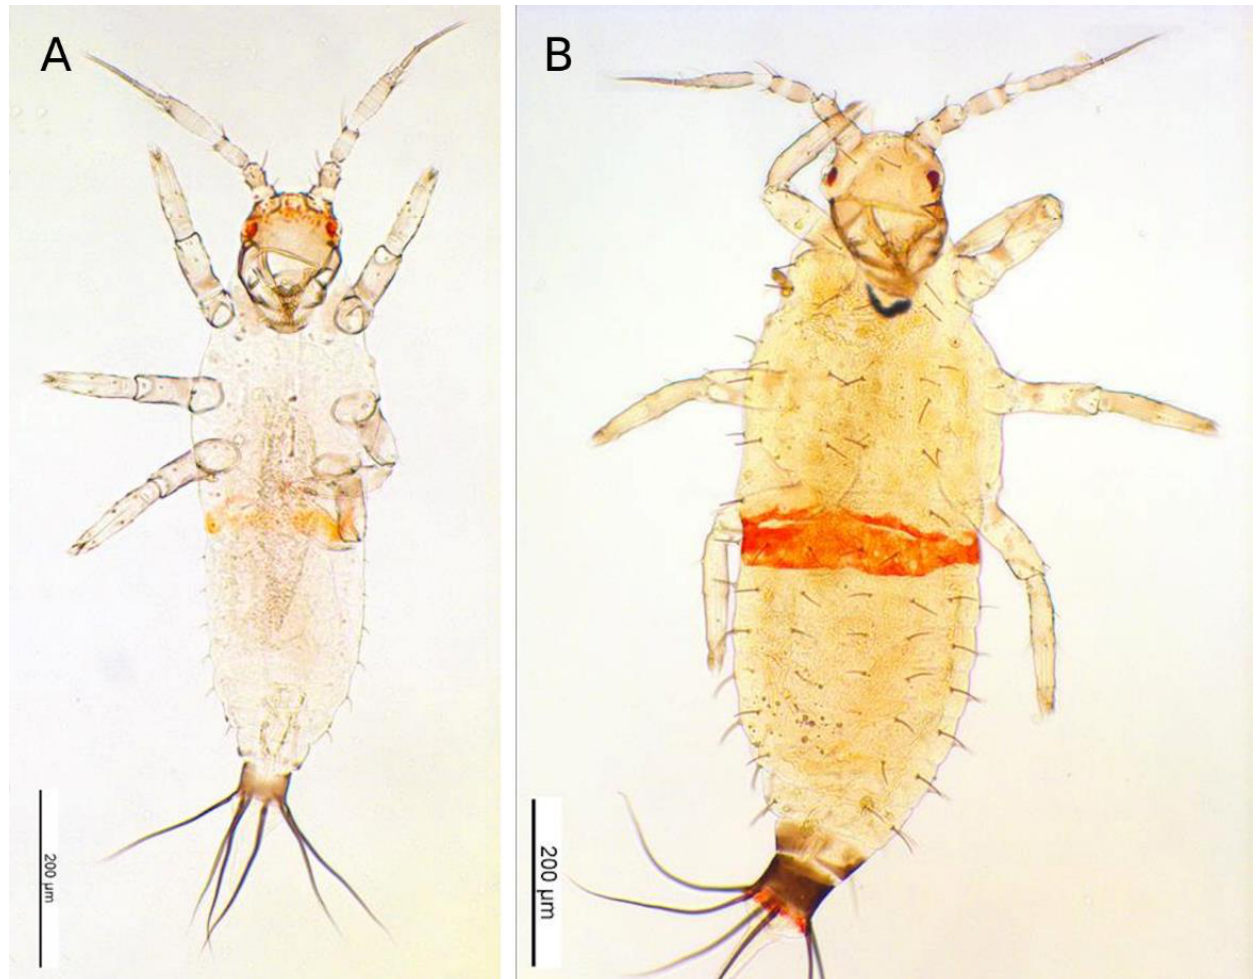
Figure A3. ( A ) larva I of S. rubrocinctus in microscopic slide, specimen collected from Liquidambar styraciflua at Crespiatica, 2019; ( B ) larva II of S. rubrocinctus in microscopic slide, specimen collected from Koelreuteria paniculata at Cremosano, 2019. Photos G. Vierbergen.